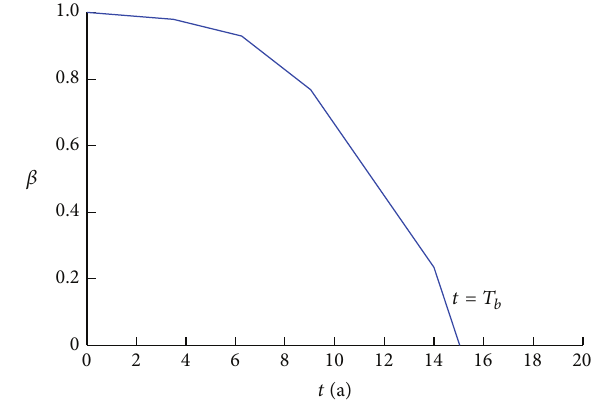
Figure 11: Effect of corrosion on reduction in pile foundation